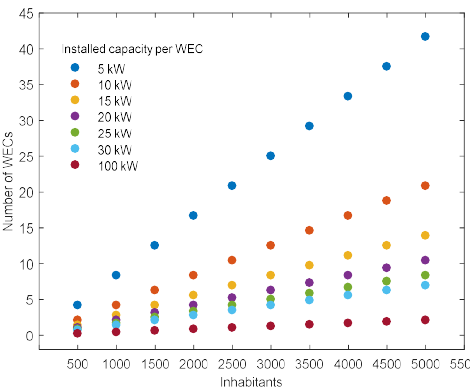
Figure 11. Number of WECs necessary for daily freshwater production as a function of number of inhabitants and installed capacity per unit WEC assuming a capacity factor of 30% and fixed energy consumption of 3 kWh/m 3 .